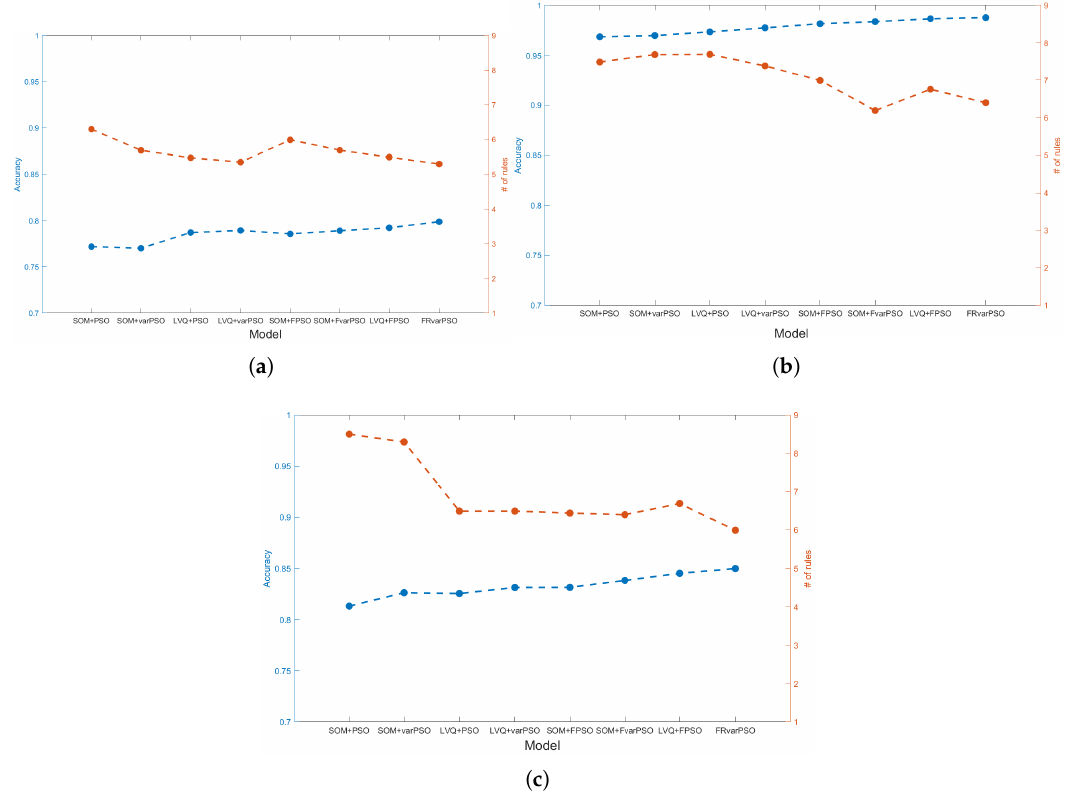
Figure 2. Comparison of the accuracy and number of rules of the different models used in this paper. ( a ) Savings and credit cooperative; ( b ) Bank dedicated to massive microcredits; ( c ) Bank dedicated to retail consumer’s